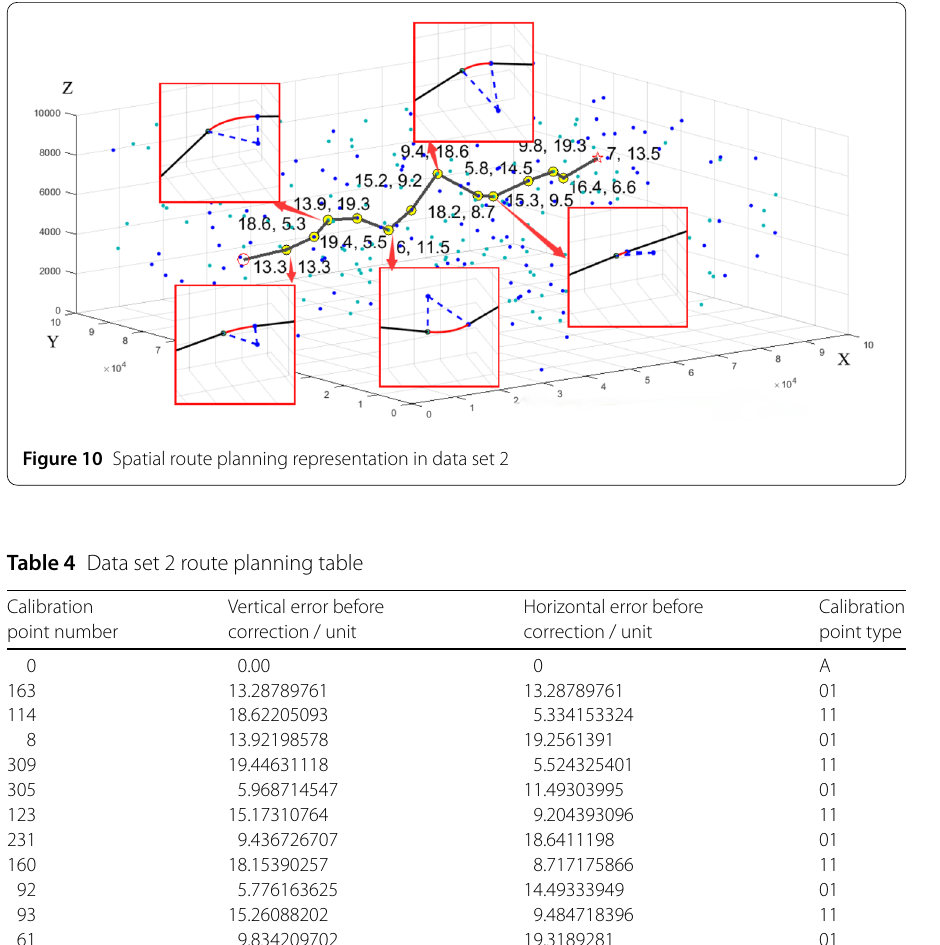
Vertical error before correction /